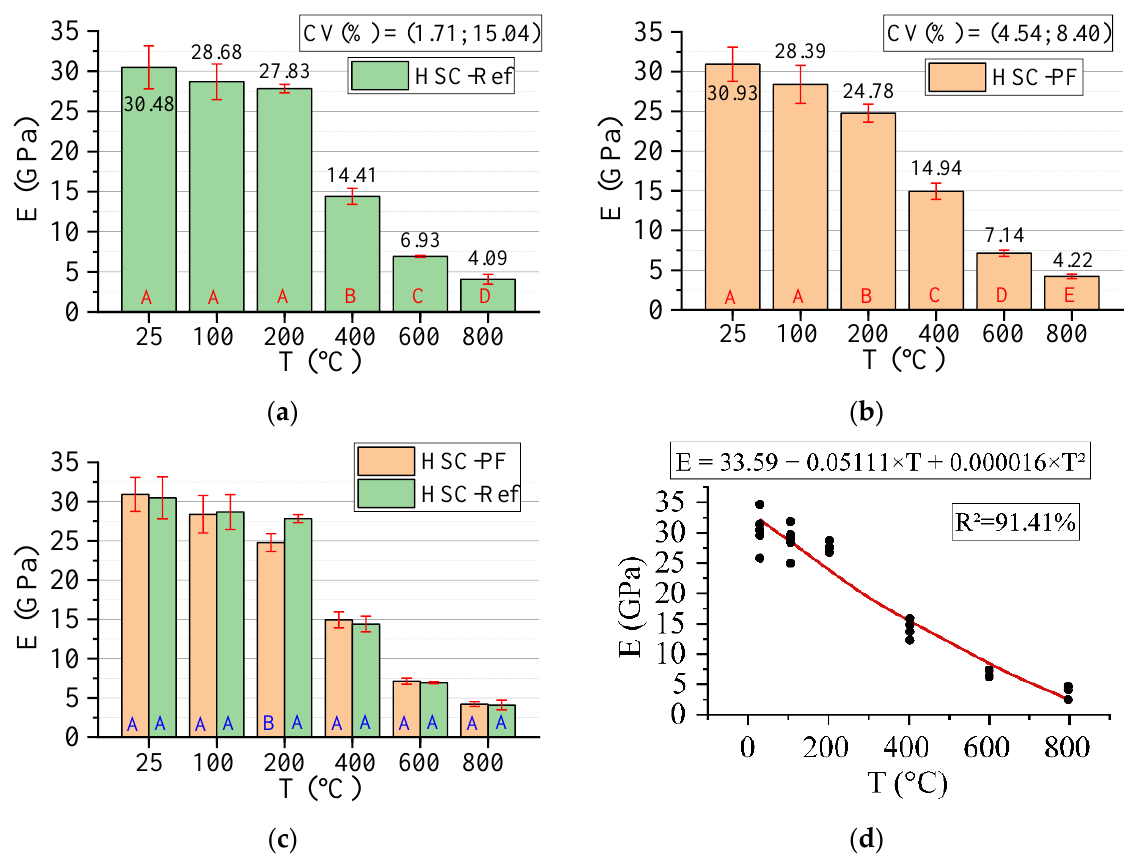
Figure 8. Elastic modulus in compression (E) results summary: ( a ) Tukey’s test for the samples without polypropylene fibers, ( b ) Tukey’s test for the samples with polypropylene fibers, ( c ) Tukey’s test for the samples without and with polypropylene fibers and ( d ) Quadratic regression model fit to the experimental data set considering only the effect of temperature as an independent factor. The uppercase letters A–E in figure mean equivalence between the sample